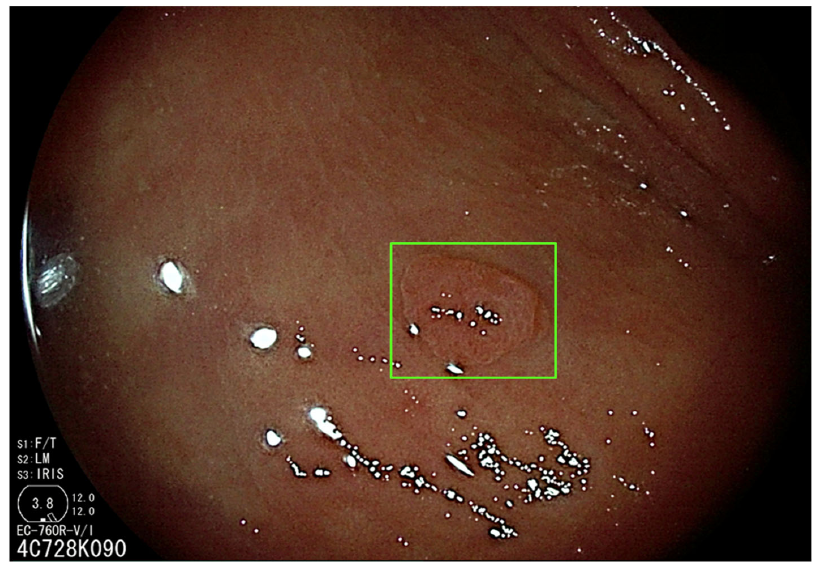
Figure 2. Application of a Computer ‐ Aided Detection (CADe) system (GI ‐ Genius, Medtronic Corp, Minneapolis, MN, USA).